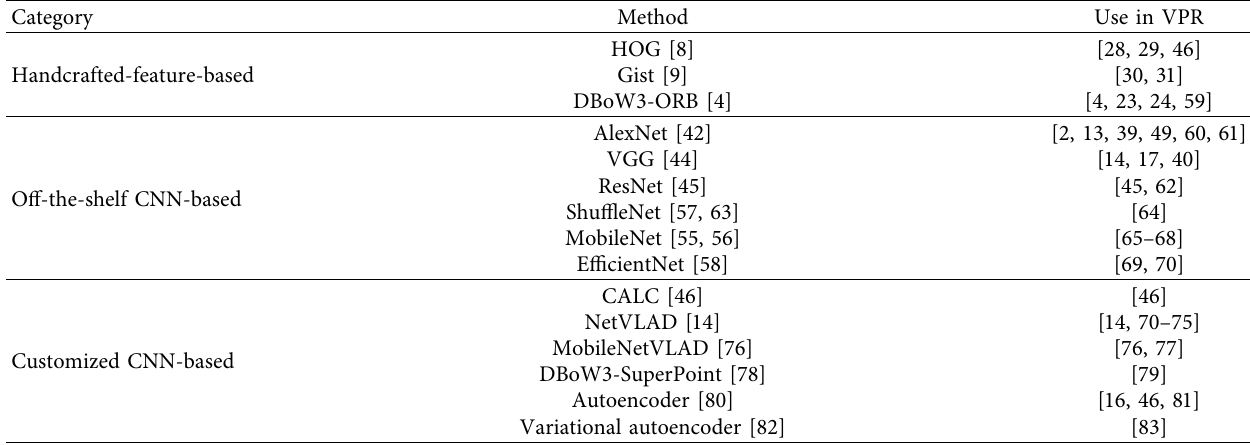
Table 1: 15 typical global feature descriptors evaluated in our